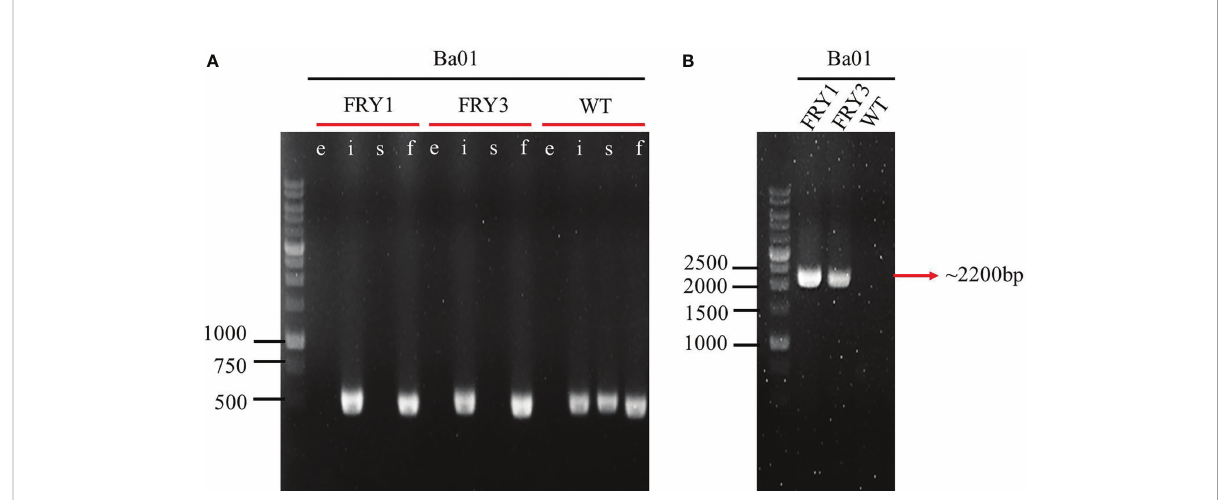
FIGURE 3 Con fi rmation of srf gene cluster mutants by PCR ampli fi cation. (A) lane e: Erm R marker (~1100 bp; JC1512/1513), lane i: ituD ORF (469 bp; JC1466/1467), lane s: srfAD ORF (485 bp; JC1468/1469), lane f: fenA ORF (455 bp; JC1470/1471). (B) Outside primer of 5 ′ and 3 ′ NCR of srf gene cluster (~2200 bp; JC1783/1784).